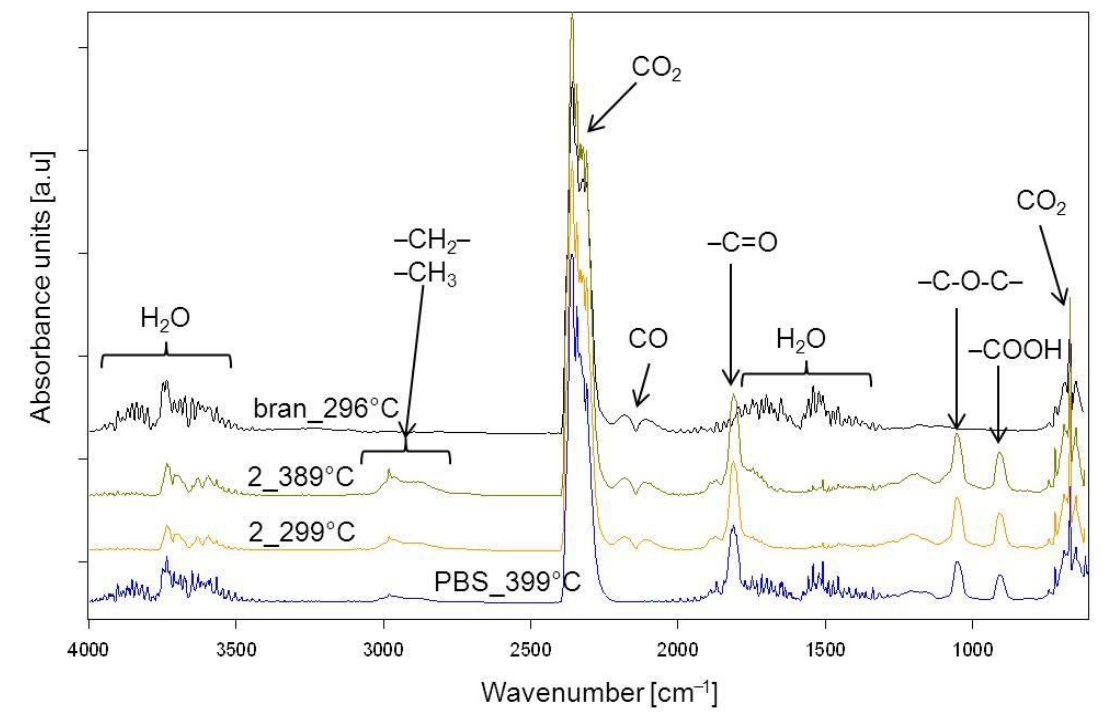
Figure 16. Extracted at the maximum value of the FTIR spectra for gaseous decomposition products of PBS, bran and biocomposite 2 obtained with 44% bran. Table 7. Parameters characterizing the thermal resistance of PBS, bran and biocomposites, obtained based on thermo- gravimetry (TG) and derivative thermogravimetry (DTG)